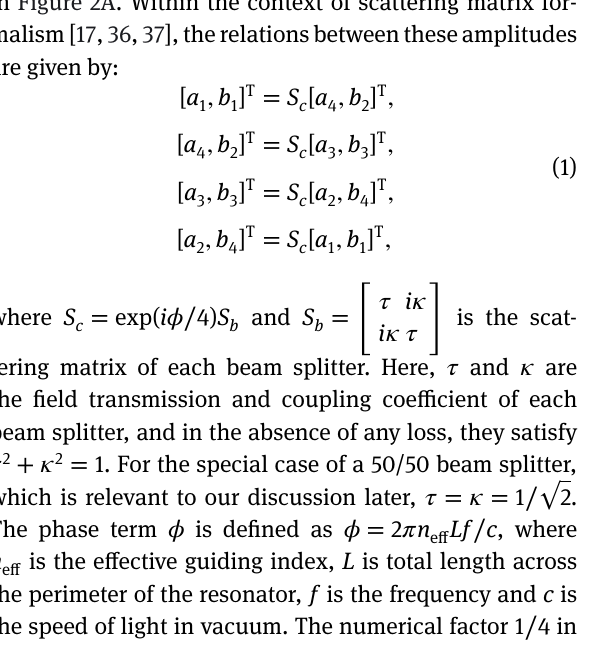
= D ′ ∪ D ′′ . The resonator can be divided into three domains: D is 1 , 2 0 0 0 and D represent the top and bottom middle sections, respectively. The field 1 2 and b , i = 1 , 2 , 3 , 4. (B) Resonant i i √ 2 as discussed in detail in the main